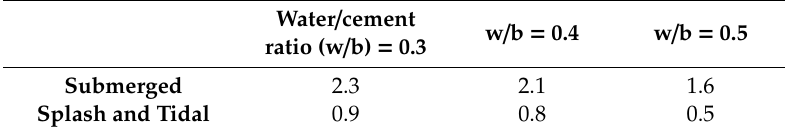
Table 5. Characteristic values of the critical chloride concentration C cr (%, relative to binder).